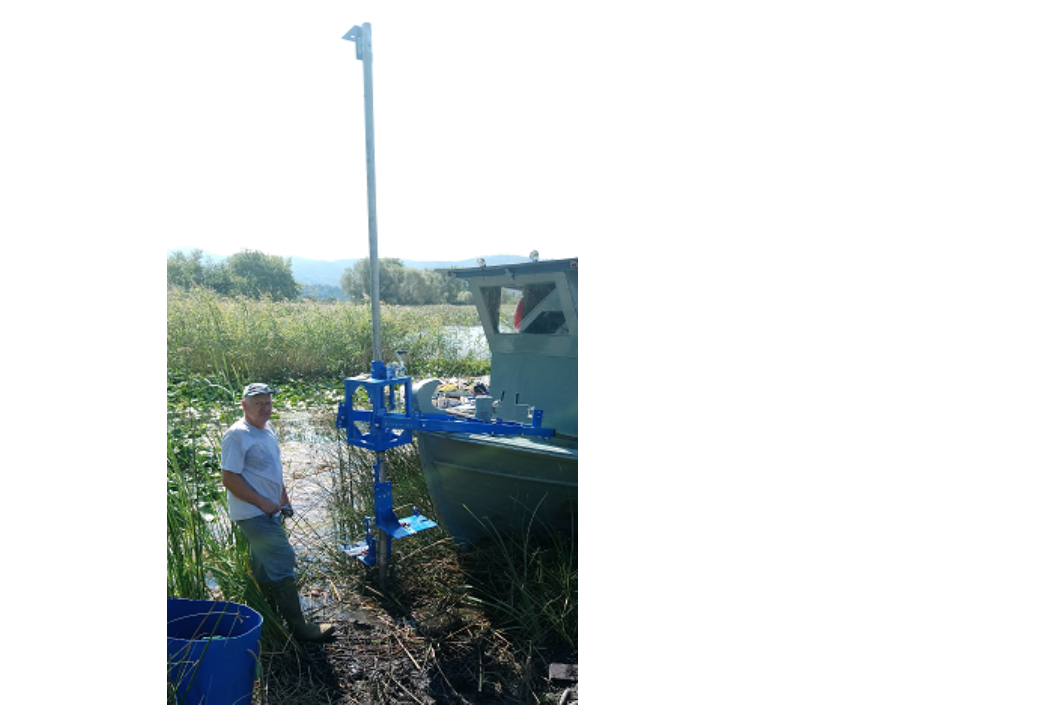
Figure 5. Echosounding traverses and sampling point locations for temperature measurements.